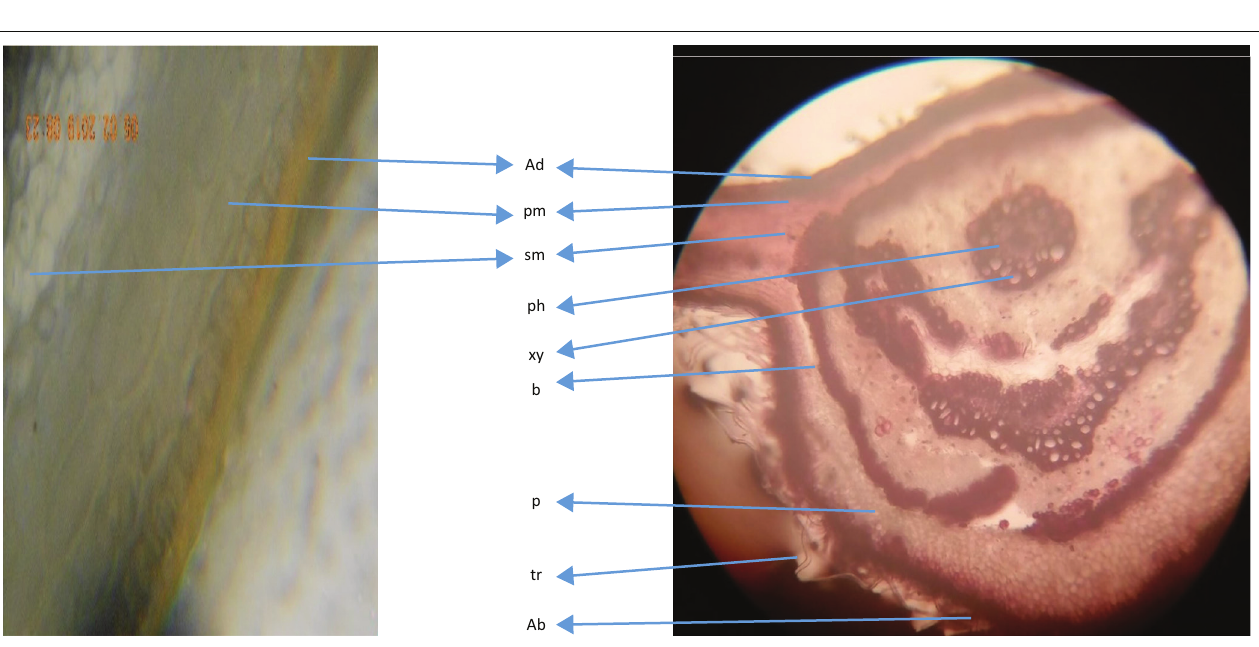
FIGURE 3: Transverse section of Isoberlinia tomentosa with enlarge palisade parenchyma cells and a whole section. Magnification × 10.